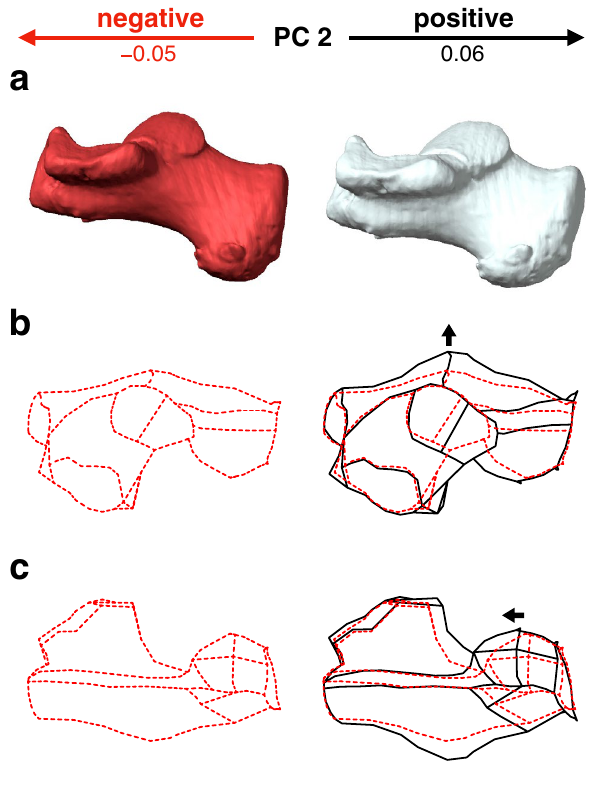
Figure 8. Shape variations represented by PC2 in the ape-only analysis. Shape variations are visualized using the wireframe connecting primary landmarks and the template surface deformed using a thin-plate spline function. Black line and white surface: PC2 = 0.06. Red line and red surface: PC2 = − 0.05. Black arrows indicate characteristics of the positive score. The medial ( a ), superior ( b ), and inferior ( c ) views were